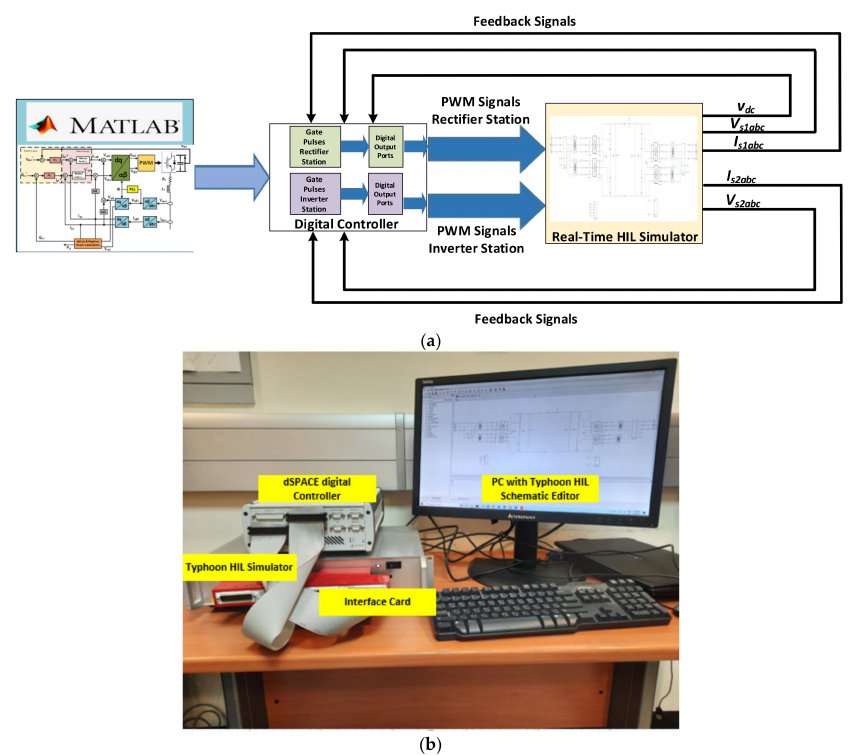
Figure 17. ( a ) Schematic; ( b ) picture of the experimental setup.